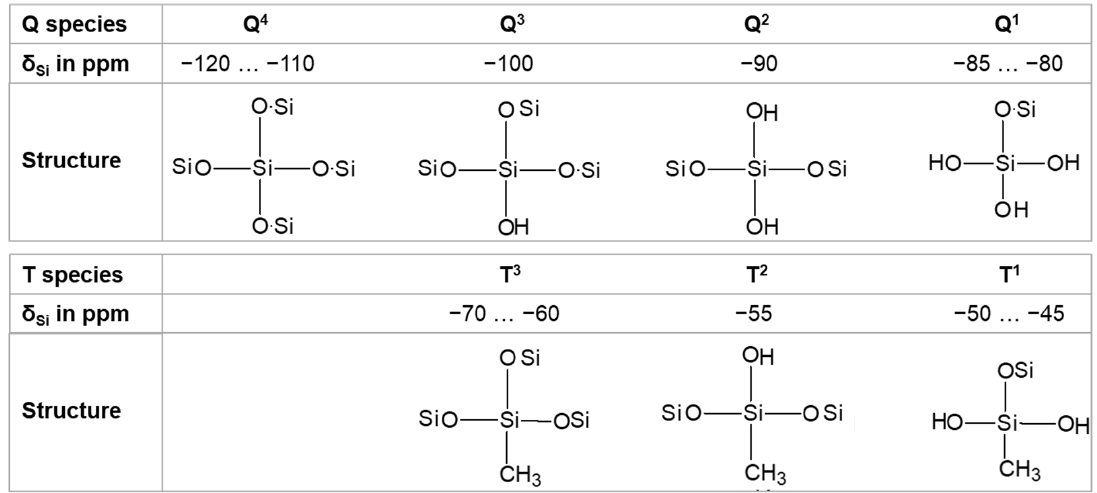
Figure 2. Structures and signals of silica and trifunctional silanes in the 29 Si ‐ MAS ‐ NMR spectrum.